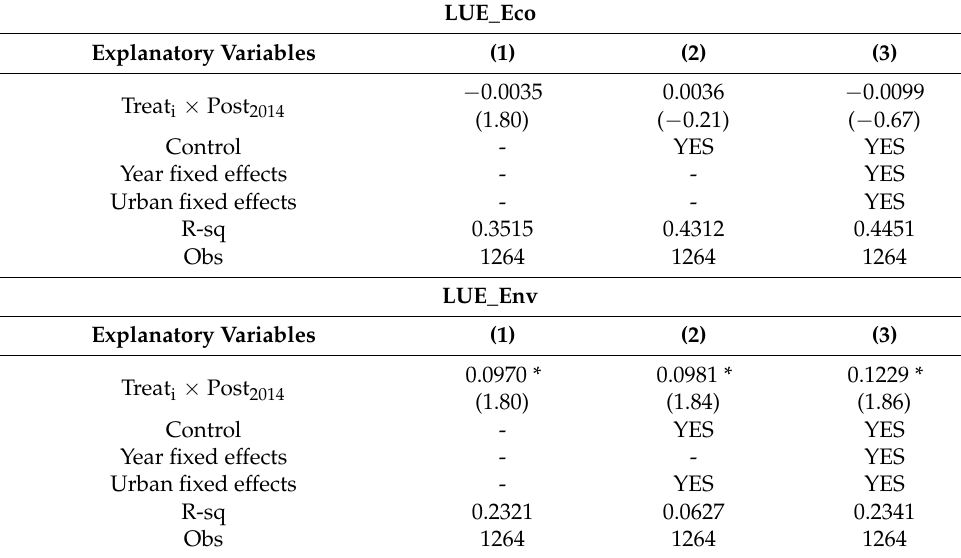
Table 3. Regression results of